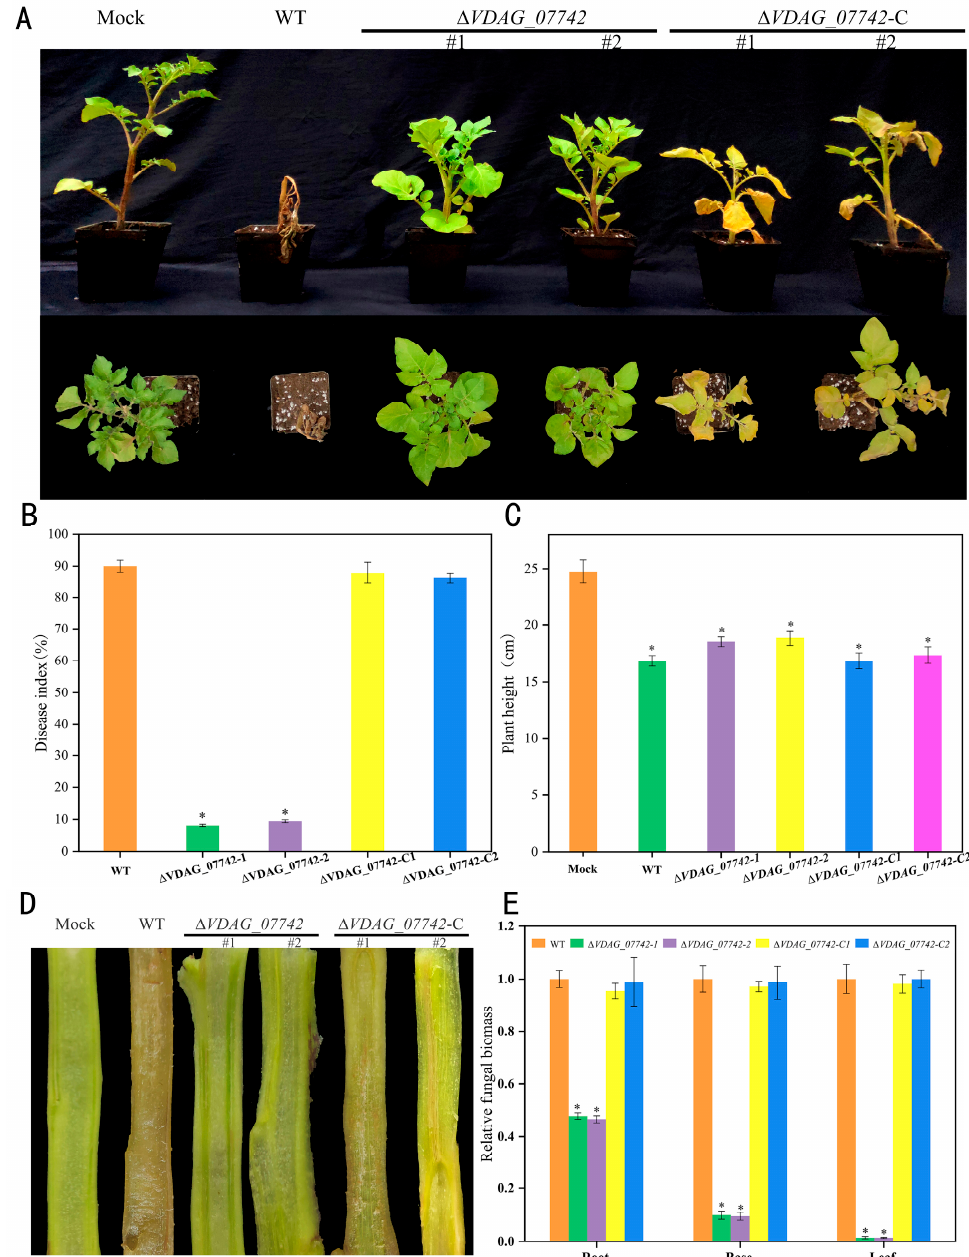
Figure 7. VDAG_07742 is required for pathogenicity of Verticillium dahliae . ( A ) Potato seedlings at the 6-leaf stage were inoculated with spore suspensions of wild-type (WT) V. dahliae strain JY, the knockout mutants ∆ VDAG_07742 -1 and ∆ VDAG_07742 -2, and complementary mutants ∆ VDAG_07742 -C1 and ∆ VDAG_07742 -C2, for four weeks; ( B ) disease index showing Verticillium wilt; ( C ) potato plant height; ( D ) discoloration of vascular vessels in longitudinal potato plant slices; ( E ) V. dahliae biomass using potato actin as a reference gene. Values on the vertical axis represent the mean ± standard error (SE) of three biological replicates. Asterisks represent significant differences relative to WT (control), as determined by the least significant difference (LSD) test at p = 0.05.